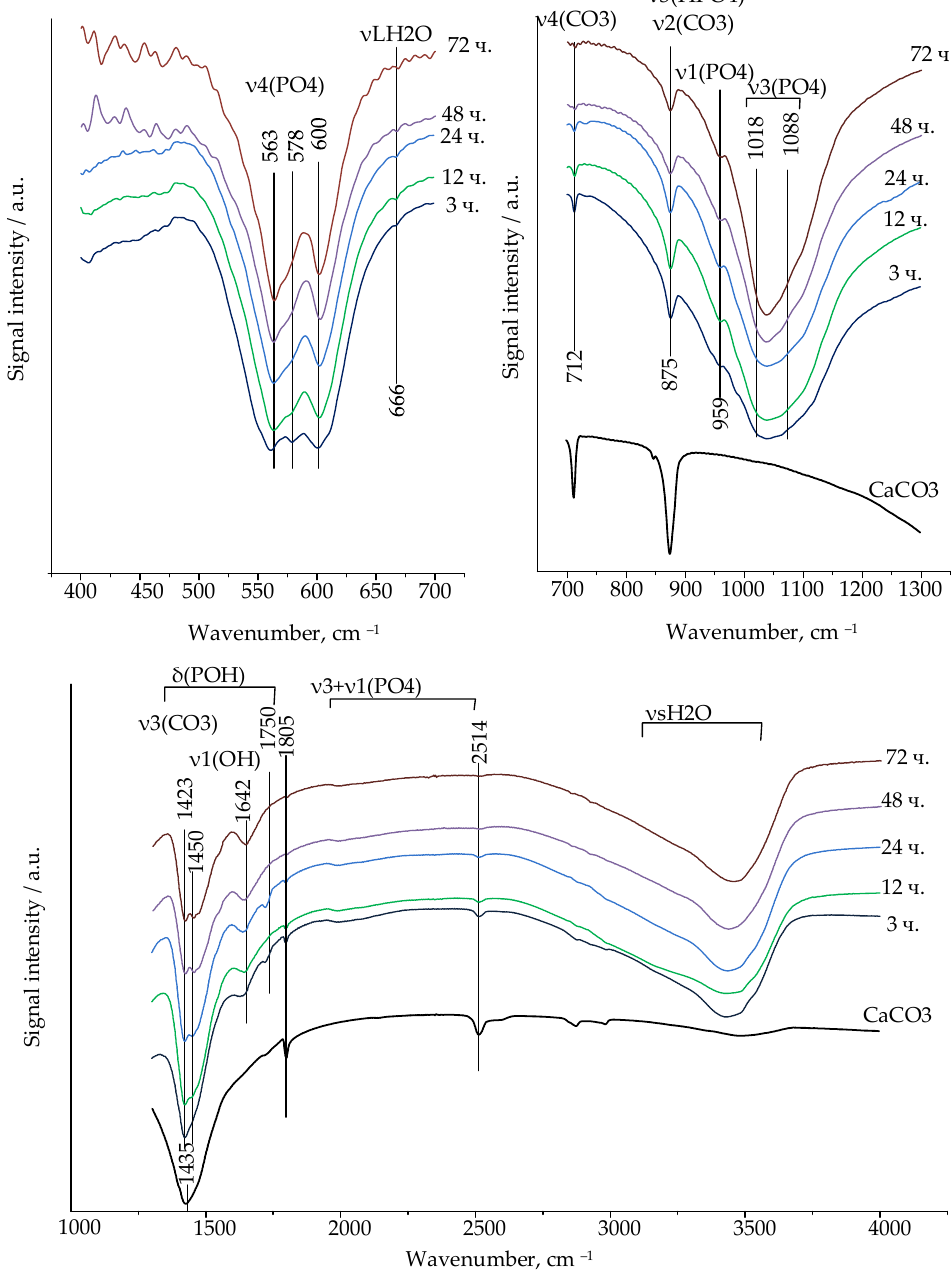
Figure 2. FTIR spectra of ceramics at different consolidation times, and FTIR spectra of calcium car- bonate.